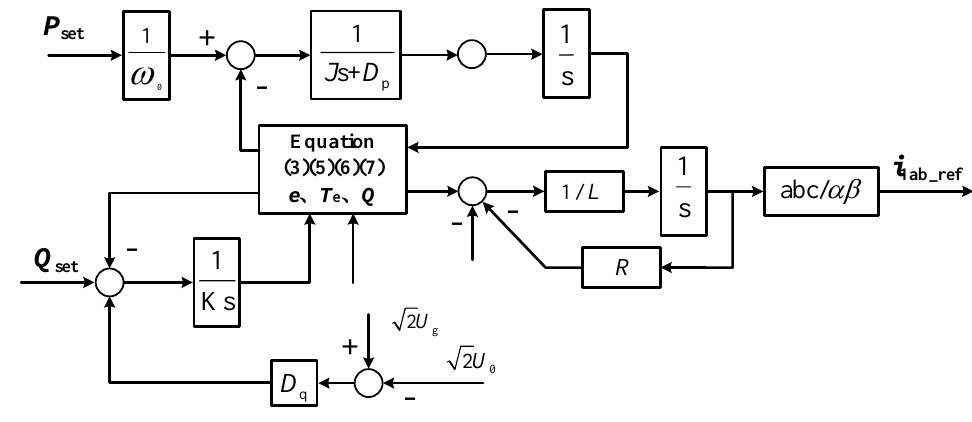
Figure 2. The control structure of the VSG.